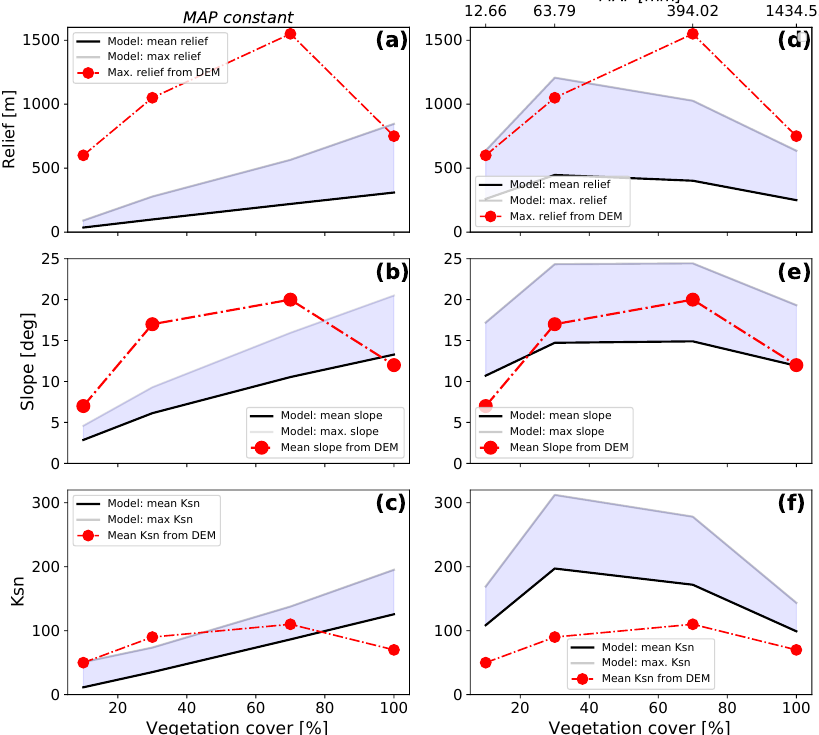
Figure 7. The steady-state model predicted (shaded regions) and observed (red dots) topographic metrics from the study areas shown in Fig. 1 for different vegetation cover amounts. Observed topographic metrics were extracted from SRTM 90m DEM. Model predicted values are shown for the cases of constant mean annual precipitation (a, b, c) or variable precipitation (d, e, f) . Variable precipitation rates and vegetation covers were selected for these simulations using the observed values from the focus areas (Fig. 5). Note that for variable precipitation and vegetation cover simulations (d, e, f) the predicted values (similar to the observations) develop a hump-shaped pattern of an increase in each parameter followed by a decrease. This suggests that changes in both precipitation and vegetation cover are needed to reproduce the general trend seen in observations. The sources of misfit between the predicted and observed values are due to the simplified (and untuned) setup of the simulations, and are discussed in the